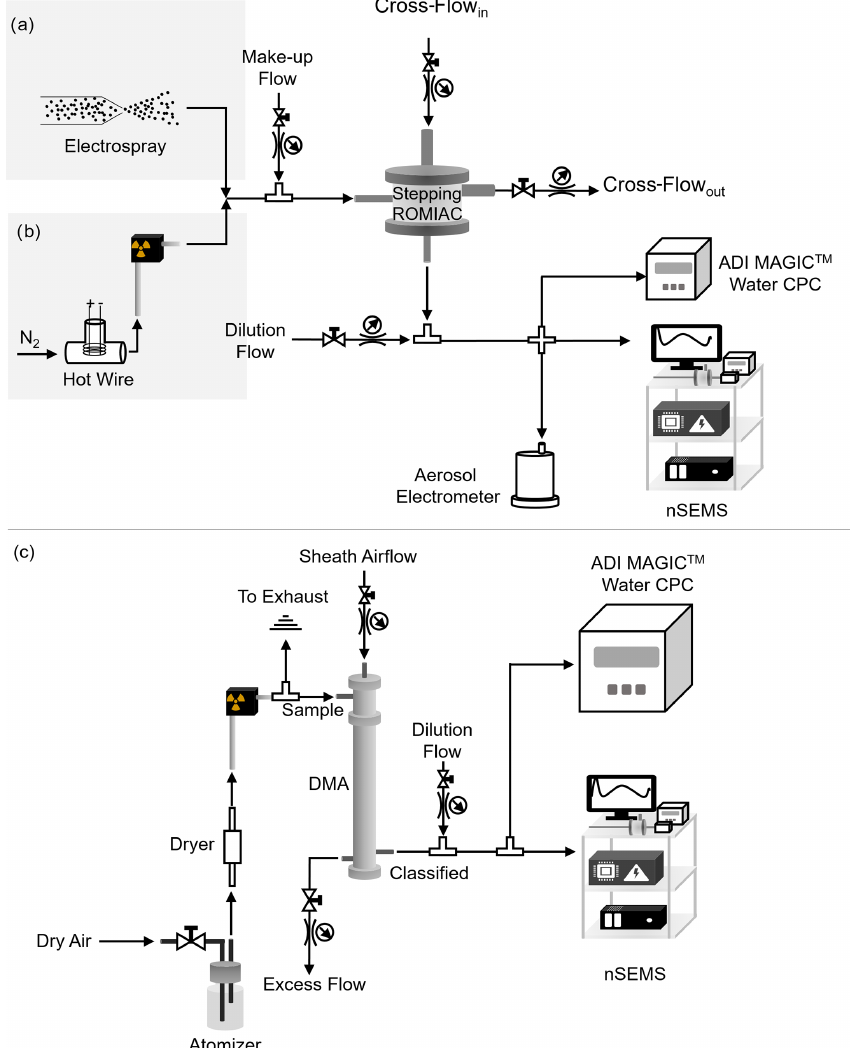
Figure 4. The experimental setup used for the nSEMS calibration and characterization in different particle size ranges. (a) < 3nm size range: tetra-alkyl ammonium ions produced by an electrospray were classified using static ROMIAC as a classifier ( R nom,nd ≈ 10) and an aerosol electrometer as a reference for the upstream particle number. The electrospray was operated at 3000V and 25cmH 2 O pressure. The tetra-alkyl ammonium solutions were prepared with 10–20mg salt in 1.5mL methanol. (b) 1.5–20nm size range: a heated Nichrome wire was employed as a hot-wire aerosol source, with a static ROMIAC as a classifier ( R nom,nd ≈ 10) and both an aerosol electrometer and ADI MAGIC™ water CPC as upstream particle counters. The hot wire was operated in the range of 5.0–7.0V and 4.5–6.5A. (c) 12.0–26.5nm size range: atomized sodium chloride was employed as an aerosol source, with a cylindrical differential mobility analyzer (DMA) as a classifier ( Q a = 0 . 5Lmin − 1 , Q sh = 5 . 8Lmin − 1 , R nom,nd ≈ 12) and an ADI MAGIC™ water CPC as an upstream particle counter. Both (b) and (c) follow a TDMA calibration setup (Rader and McMurry, 1986), which uses a classifier at a constant voltage to select particles within a narrow range of